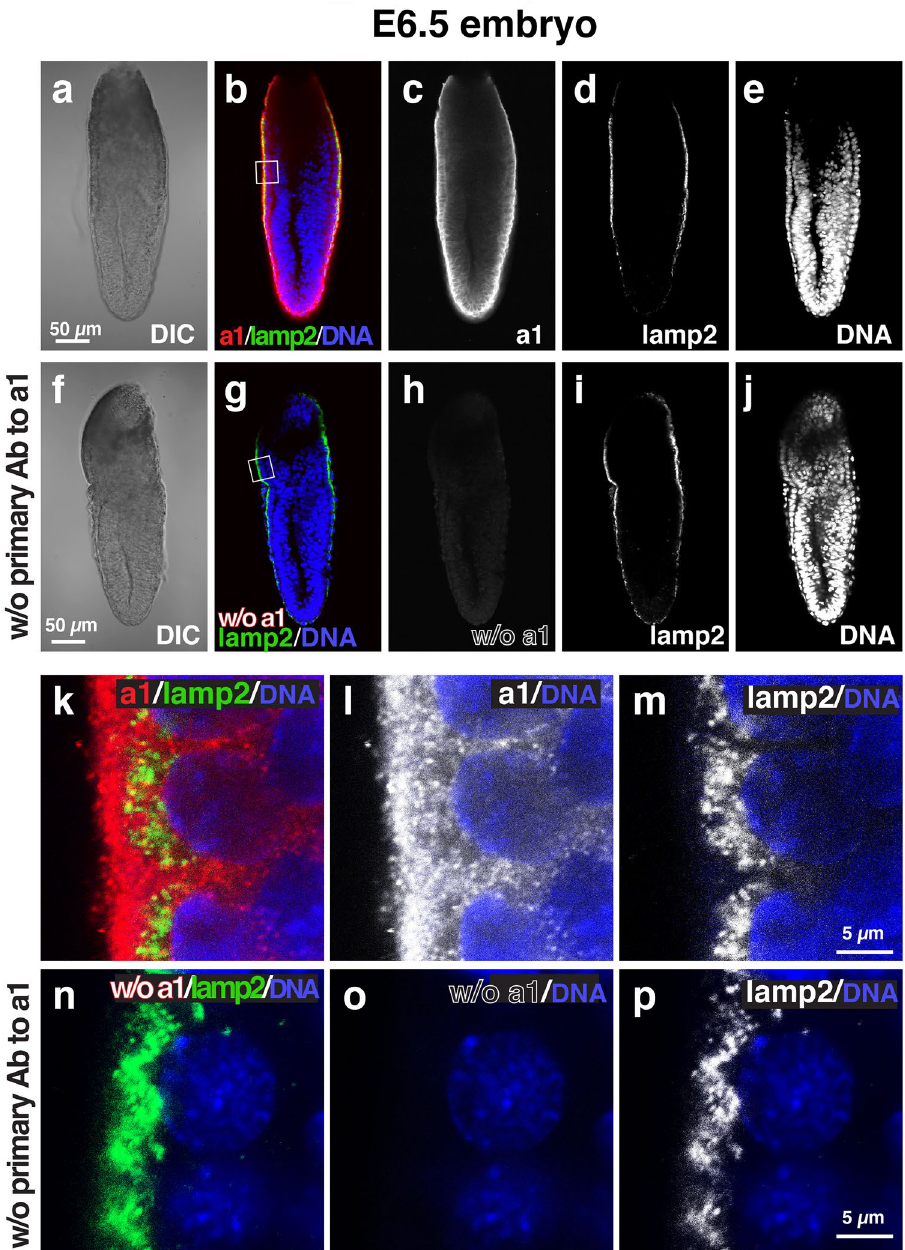
Figure 2. Localization of a1 subunit isoforms in mouse E6.5 embryos. Wild-type E6.5 embryos (n = 8) were isolated and stained with antibodies against a1 (red) and lamp2 (green). Nuclear DNA is also labelled (blue). The control embryos (n = 5) labelled without the primary antibodies against a1 (w/o primary Ab to a1) was shown in ( f – j ) and ( n – p ). The secondary antibody alone controls in which the embryos were labelled without primary antibodies against the a1 isoform were performed in parallel and the images were obtained under the same microscopic setup. The boxed region in ( b , g ) is magnified and shown as ( k – m , n – p ), respectively. Scale bars represent 50 µm and 5 µm in ( a – j , k – p ),